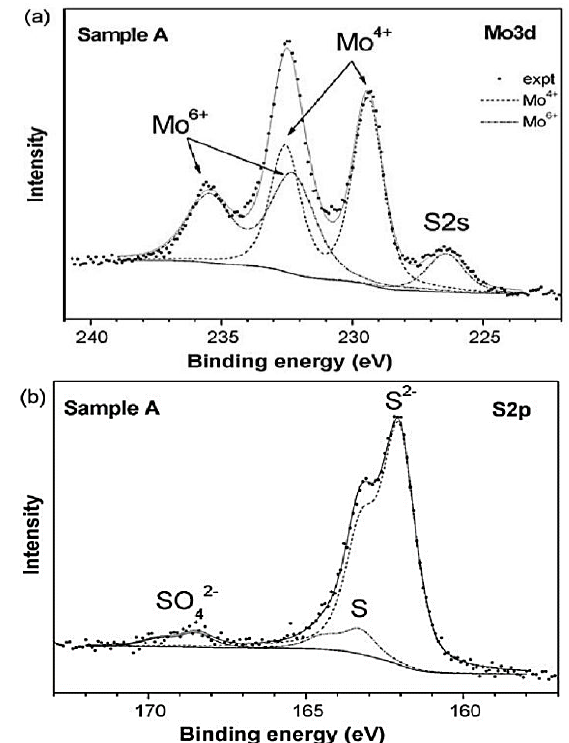
Figure 4. XPS results of molybdenite